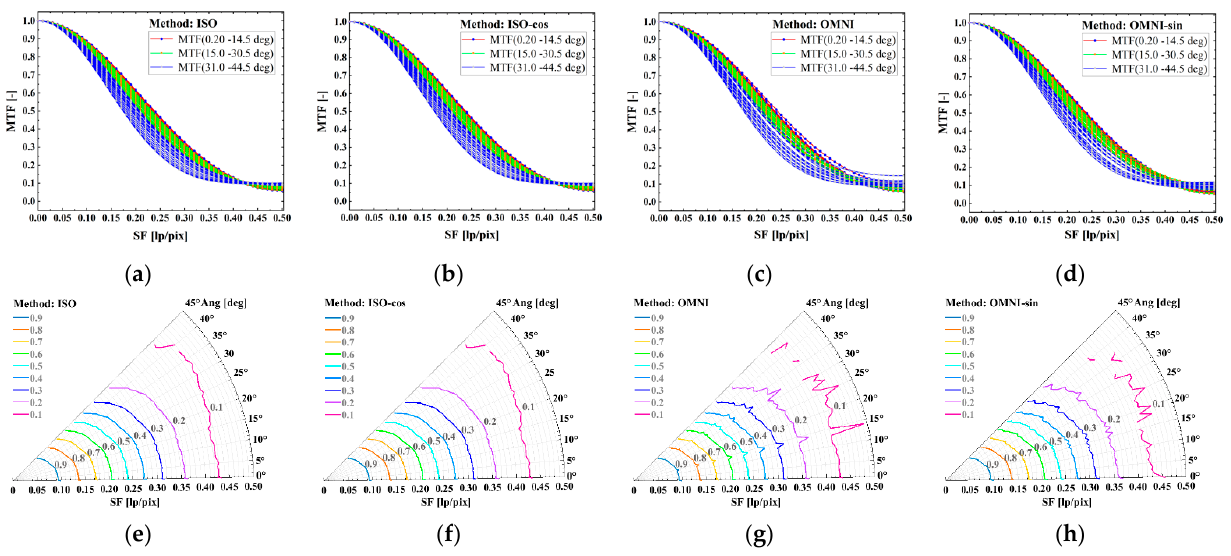
Figure 6. MTF for different tilt angle edge images vary from 0.20 deg to 44.5 deg (the angle interval is 0.50 deg) in Cartesian and polar coordinates using different modified edge methods: ( a – d ) ISO, ISO-cos, OMNI, OMNI-sin edge method in Cartesian coordinates, ( e – h ) ISO, ISO-cos, OMNI, OMNI-sin edge method in polar coordinates.